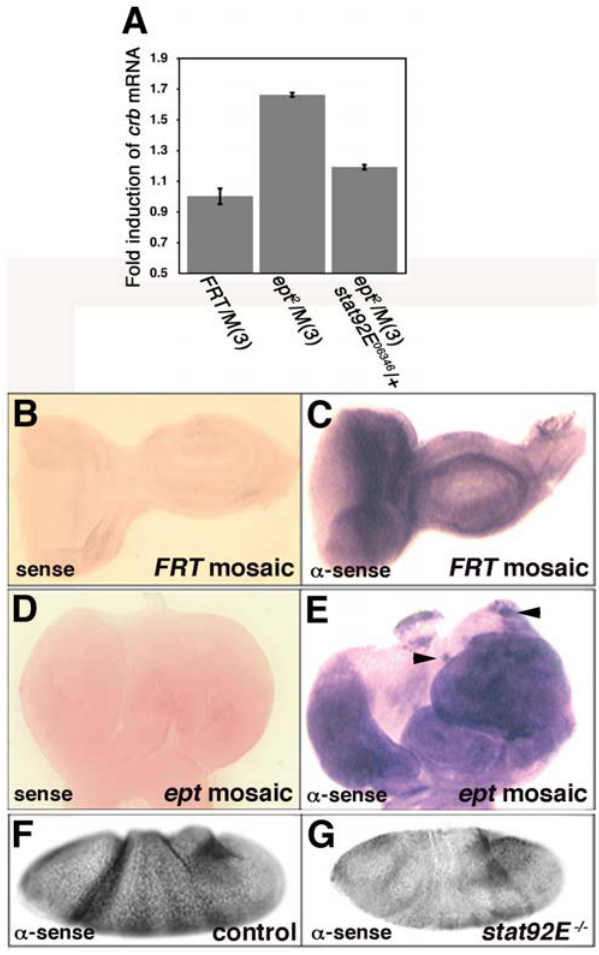
Figure 3. stat92E promotes crb expression in ept mutant cells. (A) crb transcript levels in the indicated genotypes as determined by quantitative realtime PCR. Levels of crb mRNA were normalized to control reactions to rp49 mRNA. Data represents an average of two separate experiments. (B–G) RNA in situ hybridization analysis with crb sense (B,D) or anti-sense (C,E,F,G) probes in eye discs (B–E) or stage 3 embryos (F,G) of the indicated genotypes. Arrowheads in (E) indicate patches of cells that appear to contain higher levels of crb mRNA than surrounding cells.